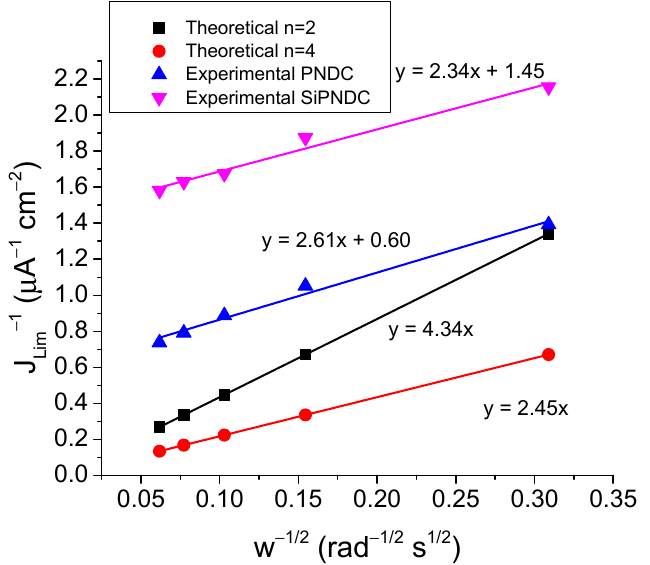
Figure 7. Koutecky–Levich plots and linear fit equations for PNDC, SiPNDC, and theoretical plots for 2-electron and 4-electron processes. Table 5 . Number of electrons and kinetic rate of oxygen reduction via PNDC and SiPNDC .